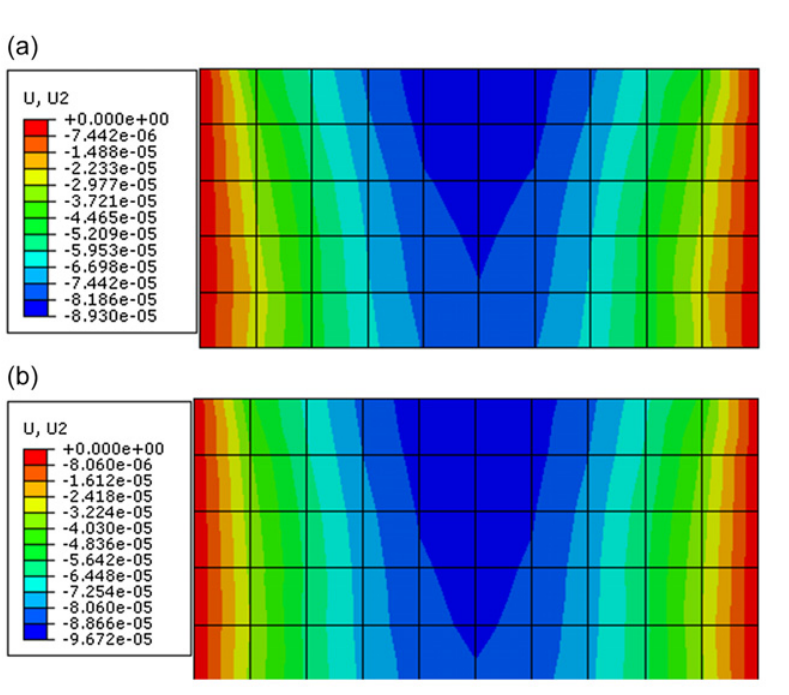
Fig 18. The vertical displacement contour of the rectangle beam calculated by different constitutive models(m) ((a) The vertical displacement contour calculated by proposed constitutive model; (b) The vertical displacement contour calculated by ubiquitous-joint